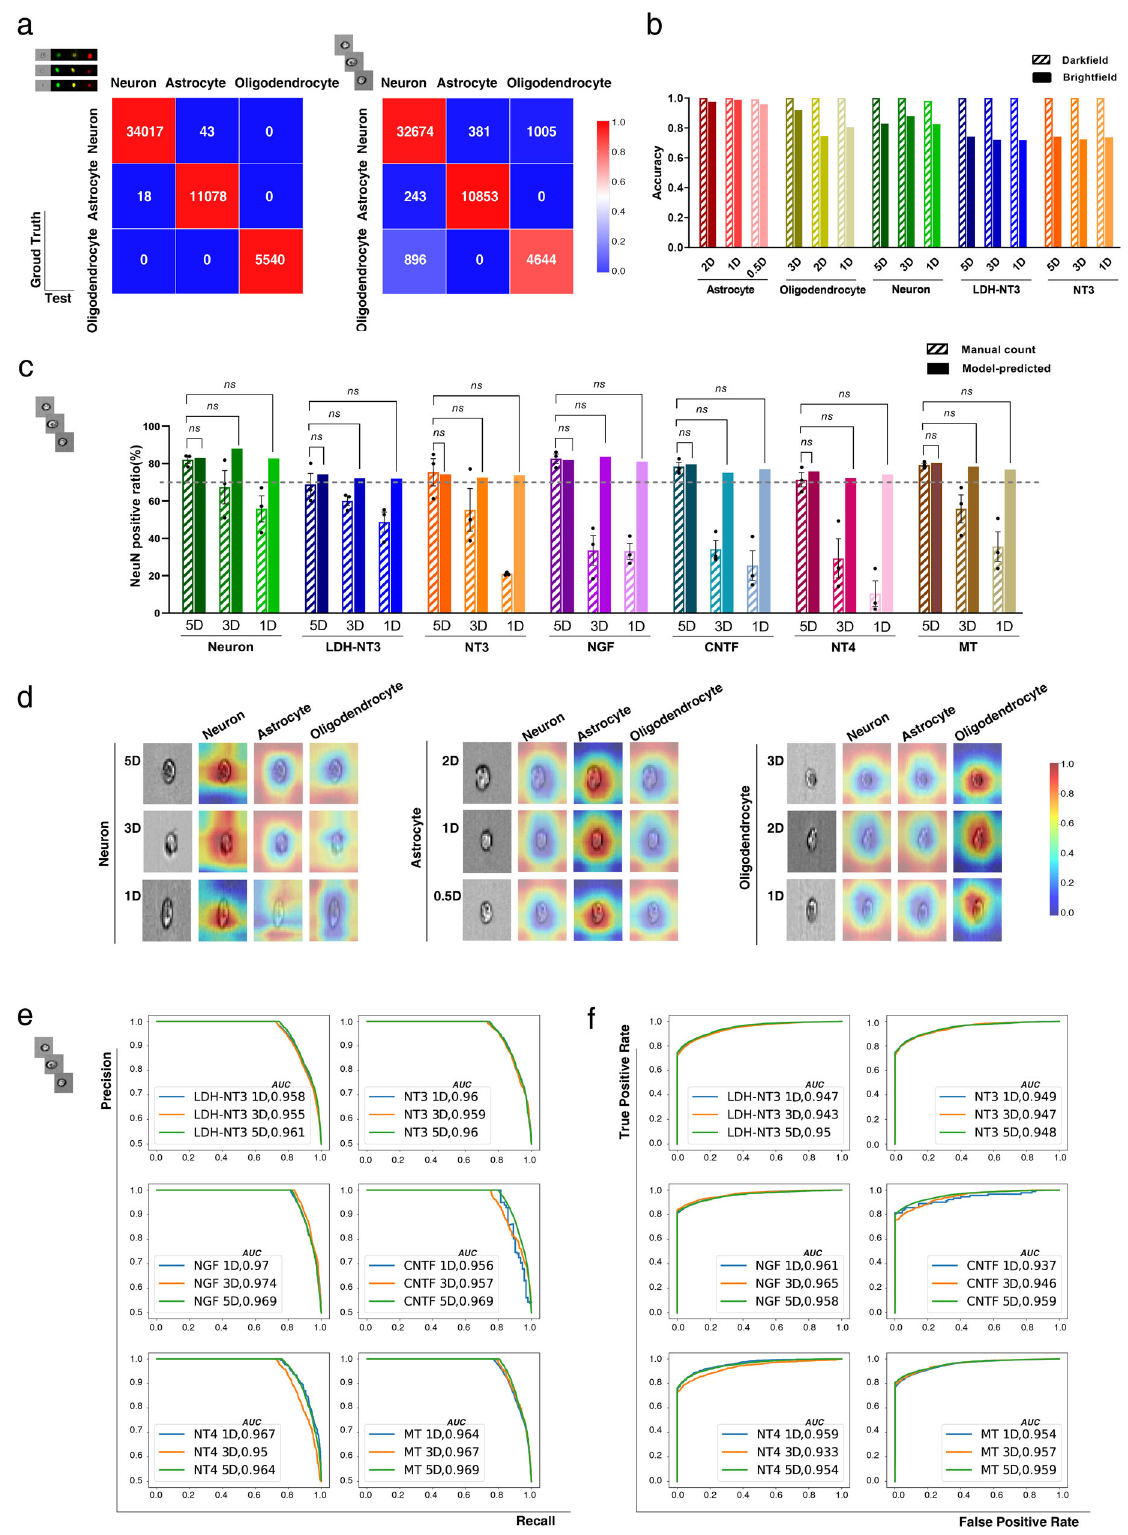
predict NSC fate within 1 day, which makes it a very valuable approach for NSC research, not only to increase ef fi ciency and reduce cost in the area of molecular screening but also to suppress interference caused by statistical errors, and markers such as GFAP, which expressed in both early differentiated NSCs and